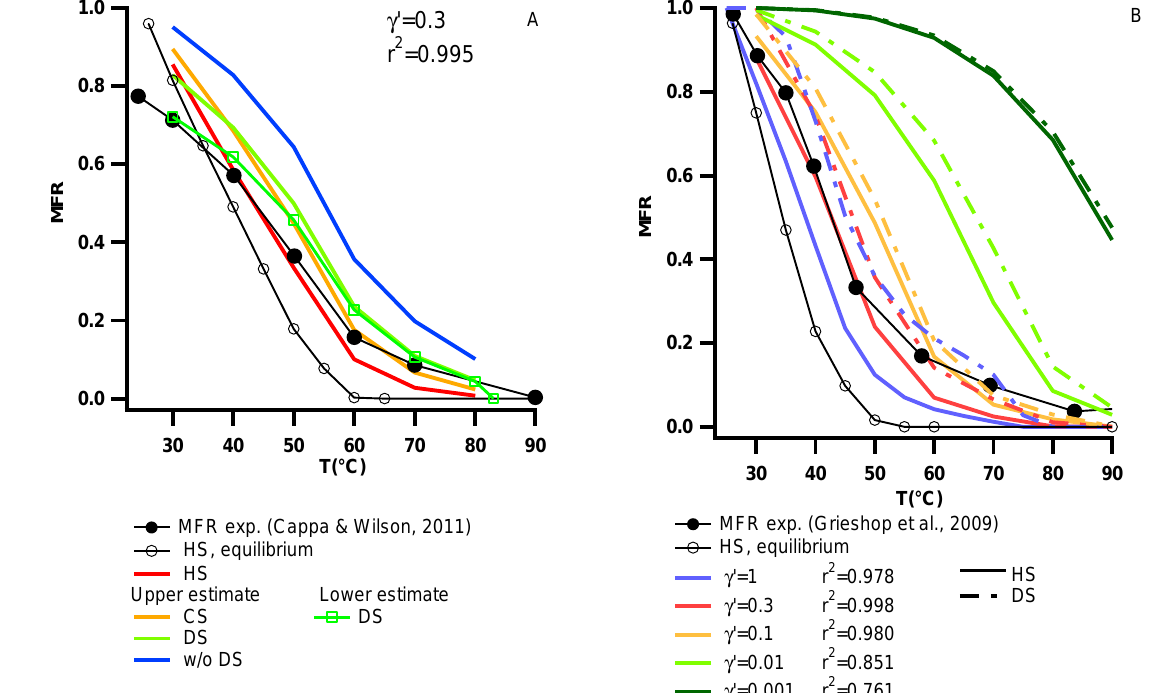
Fig. 8. (A) Output thermograms for heating section (HS), cooling section (CS) and denuder section (DS) in a system with 240nm lubricating oil particles at 650µgm − 3 aerosol loading, in comparison with experiments by Cappa and Wilson (2011). The thermodenuder system was configured as described in Cappa and Wilson (2011). (B) Thermograms reproducing experiments by Grieshop et al. (2009) with 175nm lubricating oil particles at 70µgm − 3 aerosol loading, in comparison with experimental results. Note that for this system the denuder section was directly attached at the outlet of the heating section and only output thermograms for the heating section (HS) and denuder section (DS) are provided. The specifications and operation of the thermodenuder system were as described in An et al. (2007) and Grieshop et al. (2009). In both type of experiments ( A and B ) the results show a best fit between observations and model for an effective kinetic coefficient between 0.1–1, with an optimum for γ 0 =0.3. Upper estimate: upper estimate for re-condensation (no mass transfer to walls); lower estimate: lower estimate for re-condensation (equilibrium wall